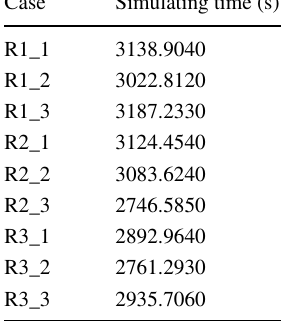
Table 5 Sequential simulation